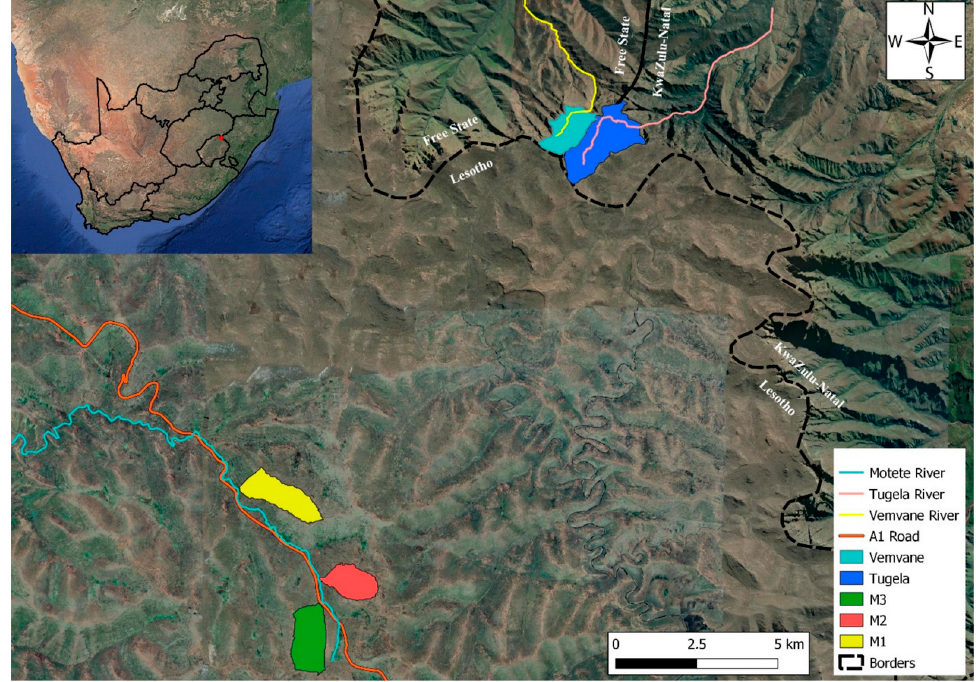
Figure 1. Tugela, Vemvane, and Motete headwater catchments. The Motete catchments are in Lesotho, whereas the Vemvane catchment in within the Free State Province in South Africa, next to the Tugela catchment.